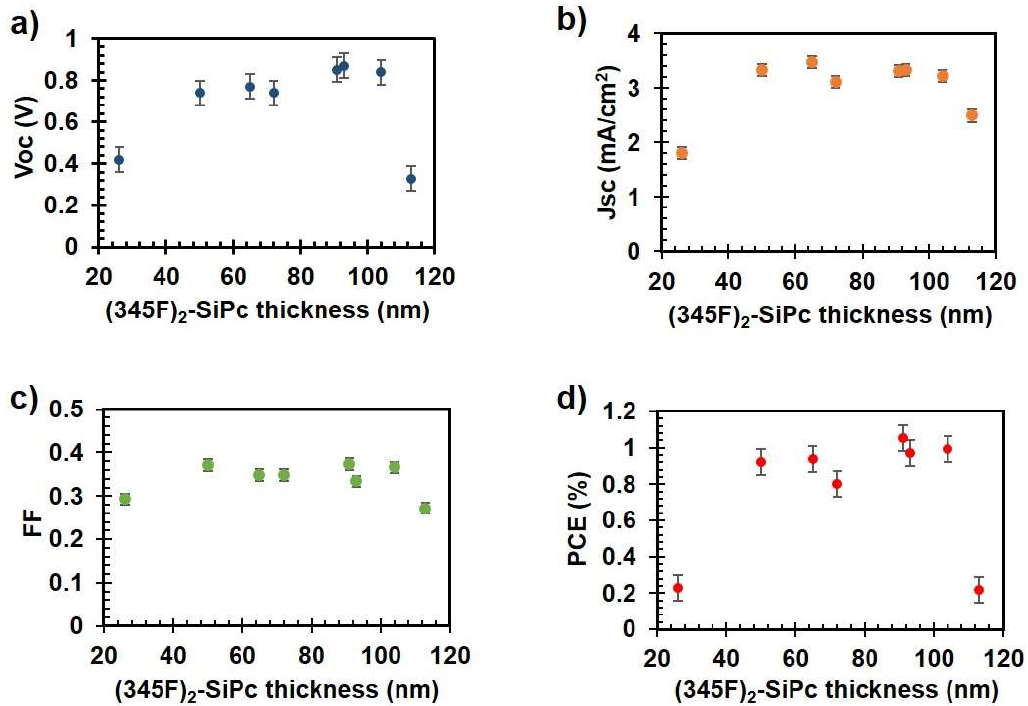
Figure 3. Average ( a ) open-circuit voltage ( V oc), ( b ) short circuit current ( J sc), ( c ) fill factor (FF), ( d ) power conversion efficiency (PCE) as a function of (345F) 2 -SiPc thickness on a film of PCDTBT.